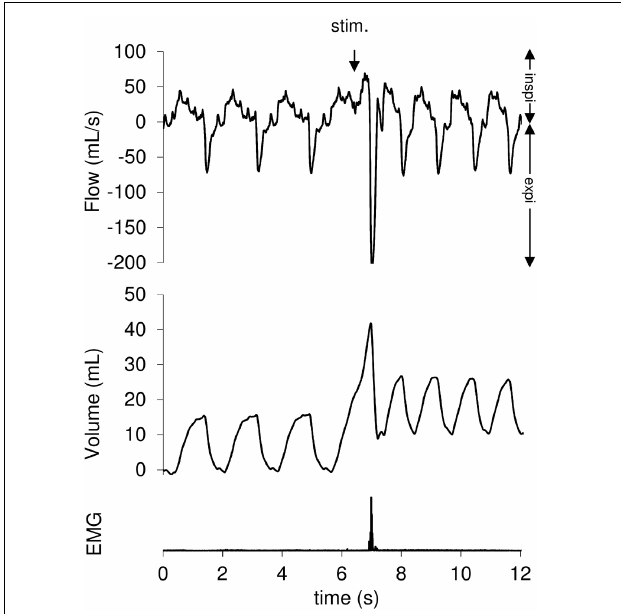
FIGURE 2 | Cough reflex following a tracheal mechanical stimulation. The cough reflex is characterized by an increase in tidal volume (V T ) associated with a concomitant increase of peak expiratory flow (˙V Emax). The downward arrow indicates tracheal stimulation (Stim.). Positive and negative airflow rates indicate inspiration (insp.) and expiration (exp.), respectively. Abdominal muscles electromyogram (EMG) also showed activity on the stimulation breath.